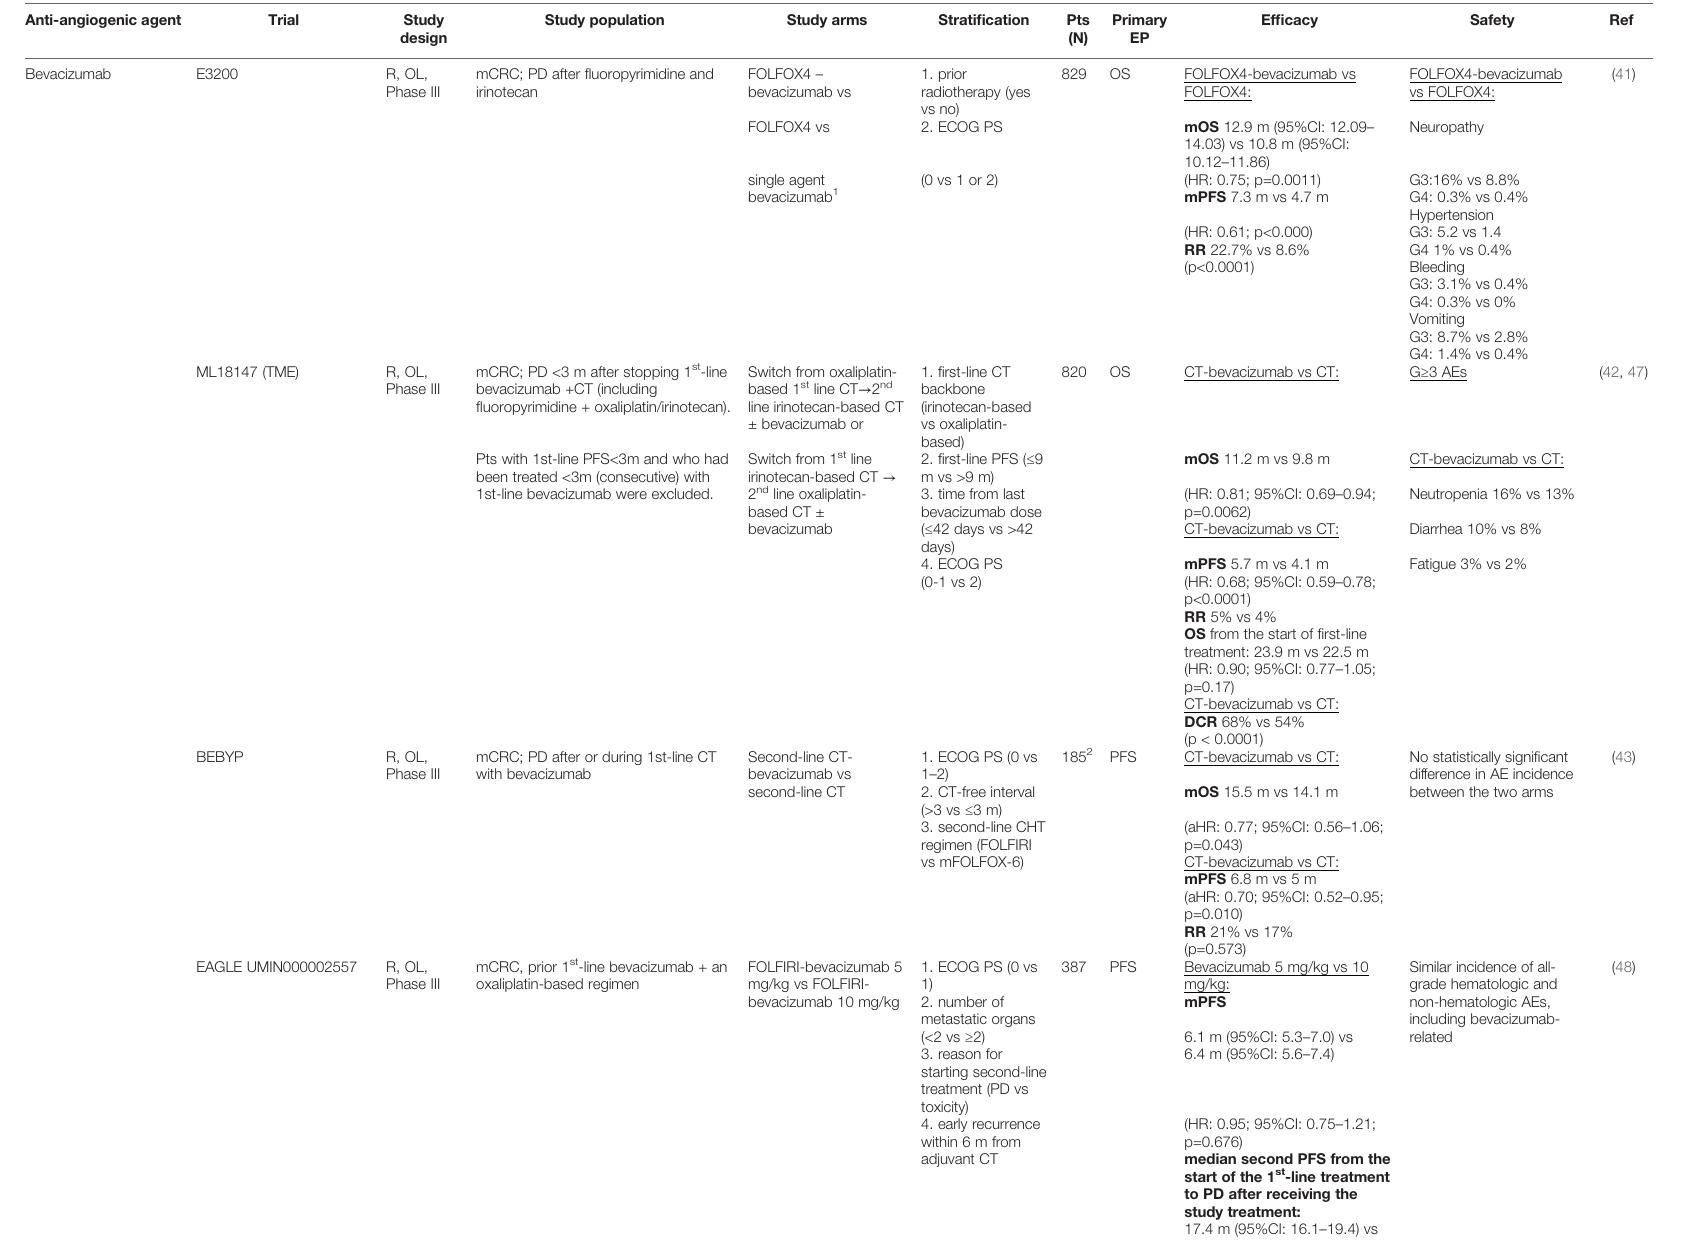
TABLE 2 | Main clinical trials of anti-angiogenic agents in the second-line